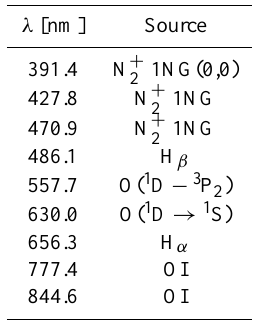
Table 1. Commonly studied visible auroral wavelengths.